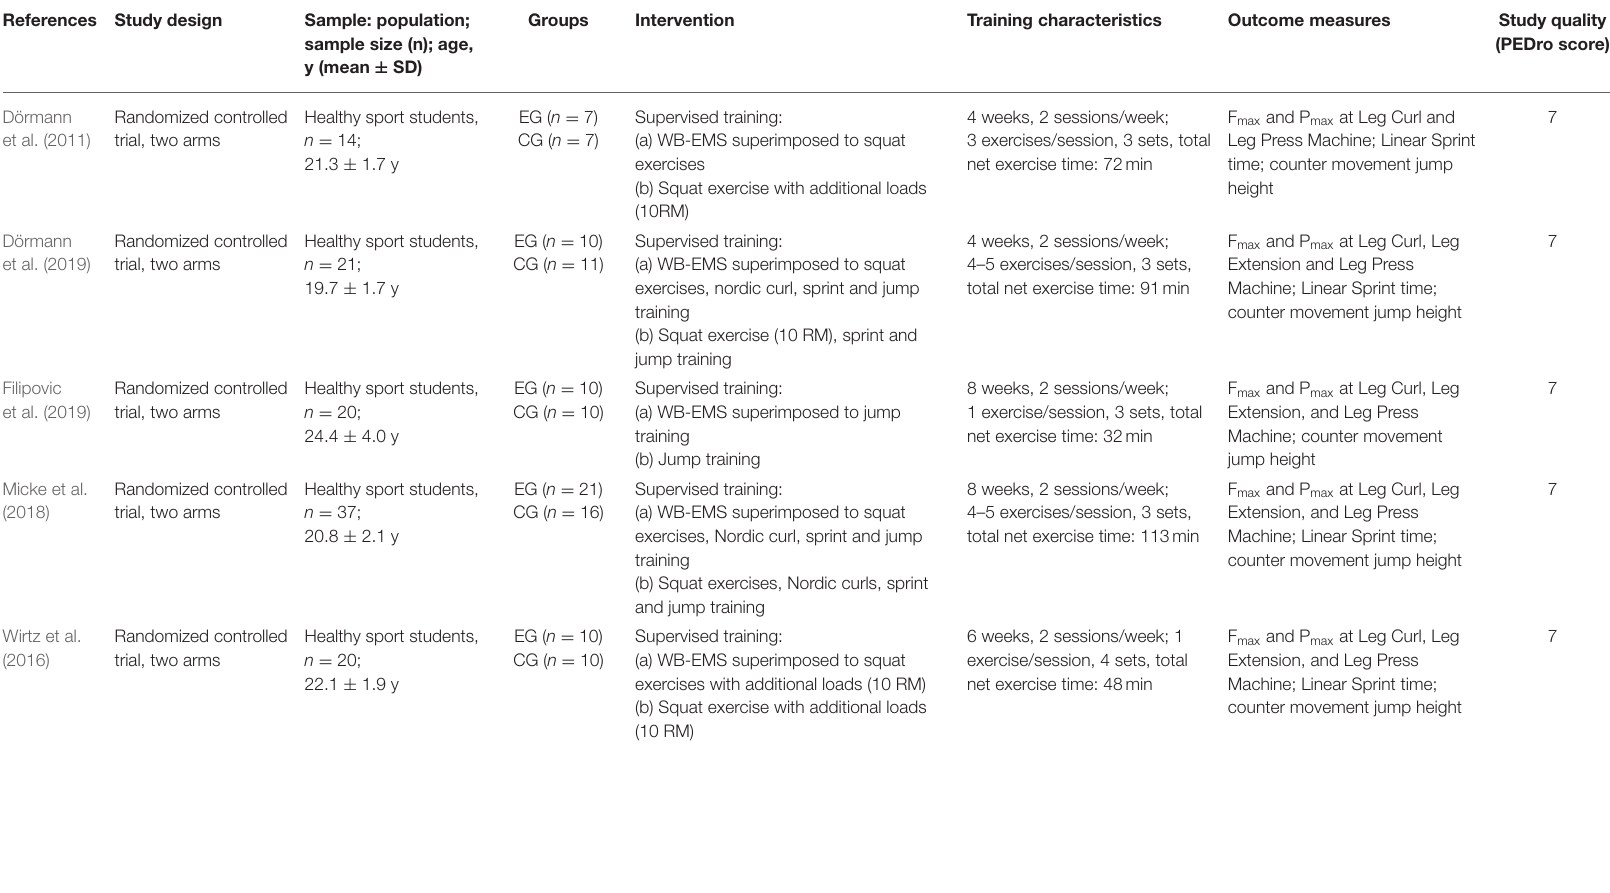
TABLE 3 | Overview of the included